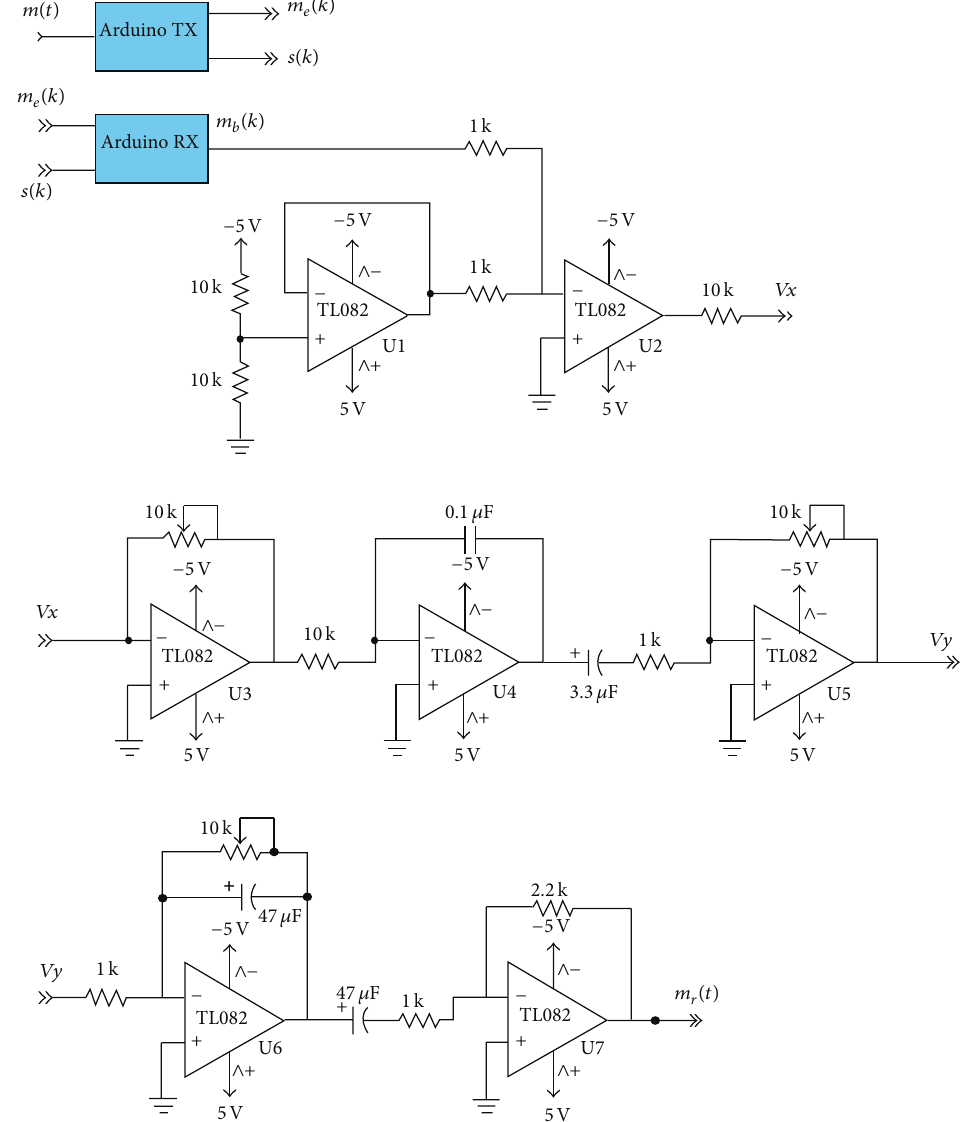
Figure 8: Circuit diagram of the analog electronics in the